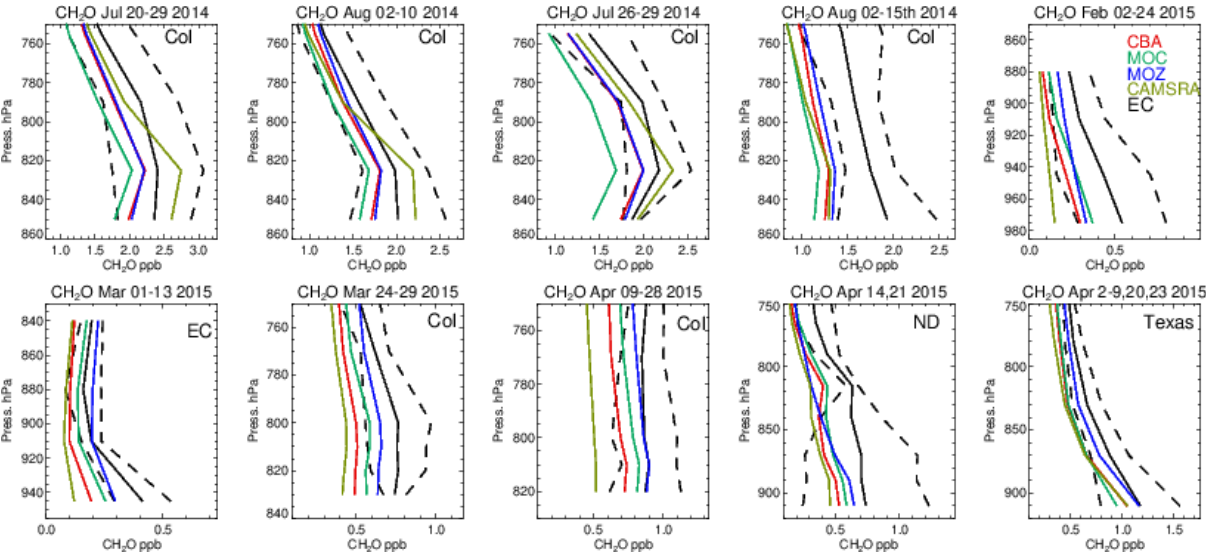
Figure 11. Comparisons of lower-tropospheric CH 2 O profiles for 2014/2015 against composites of aircraft measurements for the regional domains shown in Fig. 1. Campaigns shown (top left to bottom right) are DISCOVER-AQ, FRAPPE, WINTER and